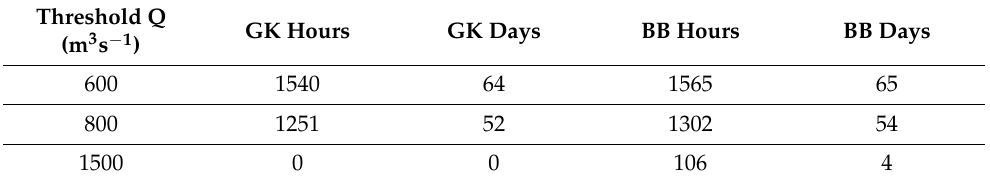
Table 7. Number of hours/days the thresholds are exceeded at BB and GK in